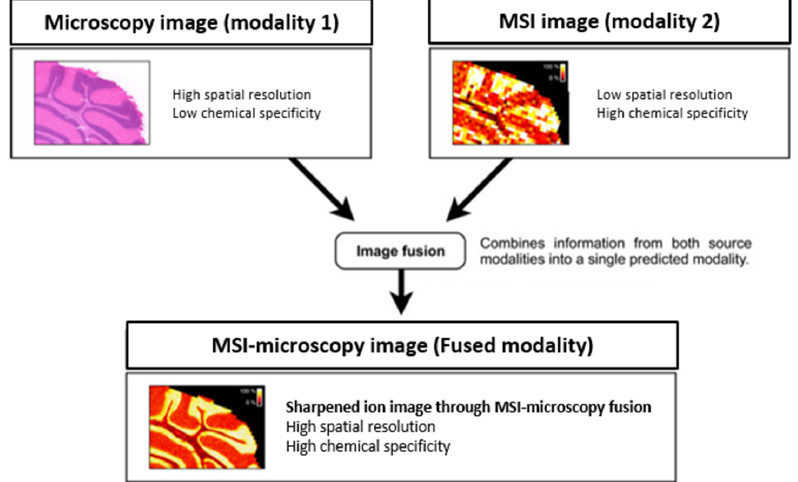
Figure 3. Example of MSI-microscopy fusion by combining high chemical information, obtained with lower spatial resolution (100 µ m), with high spatial resolution obtained with microscopy (10 µ m). The resulting MSI-microscopy fused image is a predictive modality that delivers both chemical specificity and high spatial resolution in one integrated modality. Adapted with permission from Van de Plas et al. 2015 (Nat Methods).